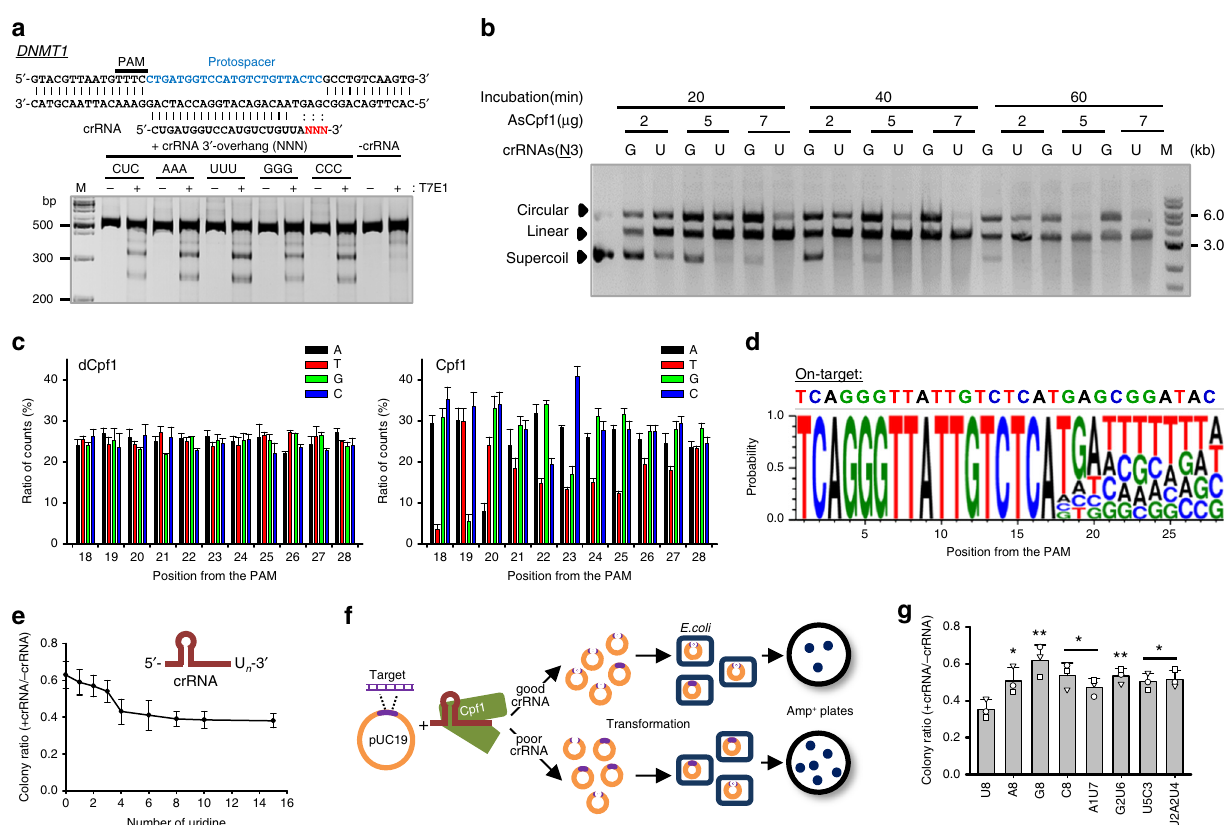
Fig. 1 Improved dsDNA breakage ef fi ciency of Cpf1 in vitro by U-rich crRNA. a Dependence of the indel ef fi ciency of AsCpf1 on the 3 ′ -overhang sequence of crRNA. Variations of the 3 ′ -terminal three bases of crRNA affected the AsCpf1 indel activity in vivo, and the presence of 3-mers of uridine was the most critical for the improved AsCpf1 activity. b Improved in vitro dsDNA cleavage activity of AsCpf1 by the 3 ′ -end uridine-rich crRNA. Vector constructs (500 ng) were digested in vitro in the presence of a ribonucleoprotein complex of AsCpf1 and crRNA (50 ng) at various incubation times (20 – 60 min) with variable amounts of AsCpf1 (2 – 7 μ g) in a 20- μ L reaction. c Positional ratio of nucleotide counts of crRNA template DNA in the protospacer region as assessed by deep sequencing analysis. The negatively selected E. coli cells carry less-ef fi cient crRNA-encoding plasmid DNA, thereby rendering higher count numbers in deep sequencing. dCpf1 was used to normalize the variations in the crRNA library synthesis and experimental procedures ( n = 3). All data are presented as means±standard deviations. d Optimal con fi guration of AsCpf1-crRNA for yielding the highest indel ef fi ciency. Twenty-nt target sequence should be followed by uridine-rich sequences independently of the subsequent on-target sequences in the crRNA for an optimal AsCpf1 indel activity. e Dependence of the length of the 3 ′ -end uridines of the crRNA on the in vitro AsCpf1 activity. The increment of the length of uridines of the chemically synthesized crRNAs led to the improved AsCpf1 activity in vitro with up to eight bases. f Scheme for an in vitro dsDNA breakage activity assay. Partially digested plasmids were used to transform DH-5 α E. coli cells, and the AsCpf1 activity was calculated from the number of colonies formed on non-uridine bases at any location and at any number resulted in decreased AsCpf1 activity. Data are presented as the mean±standard deviation. * p < 0.05, ** p < 0.01, compared with U 8 ( n = 3), two-tailed Student ’ s t